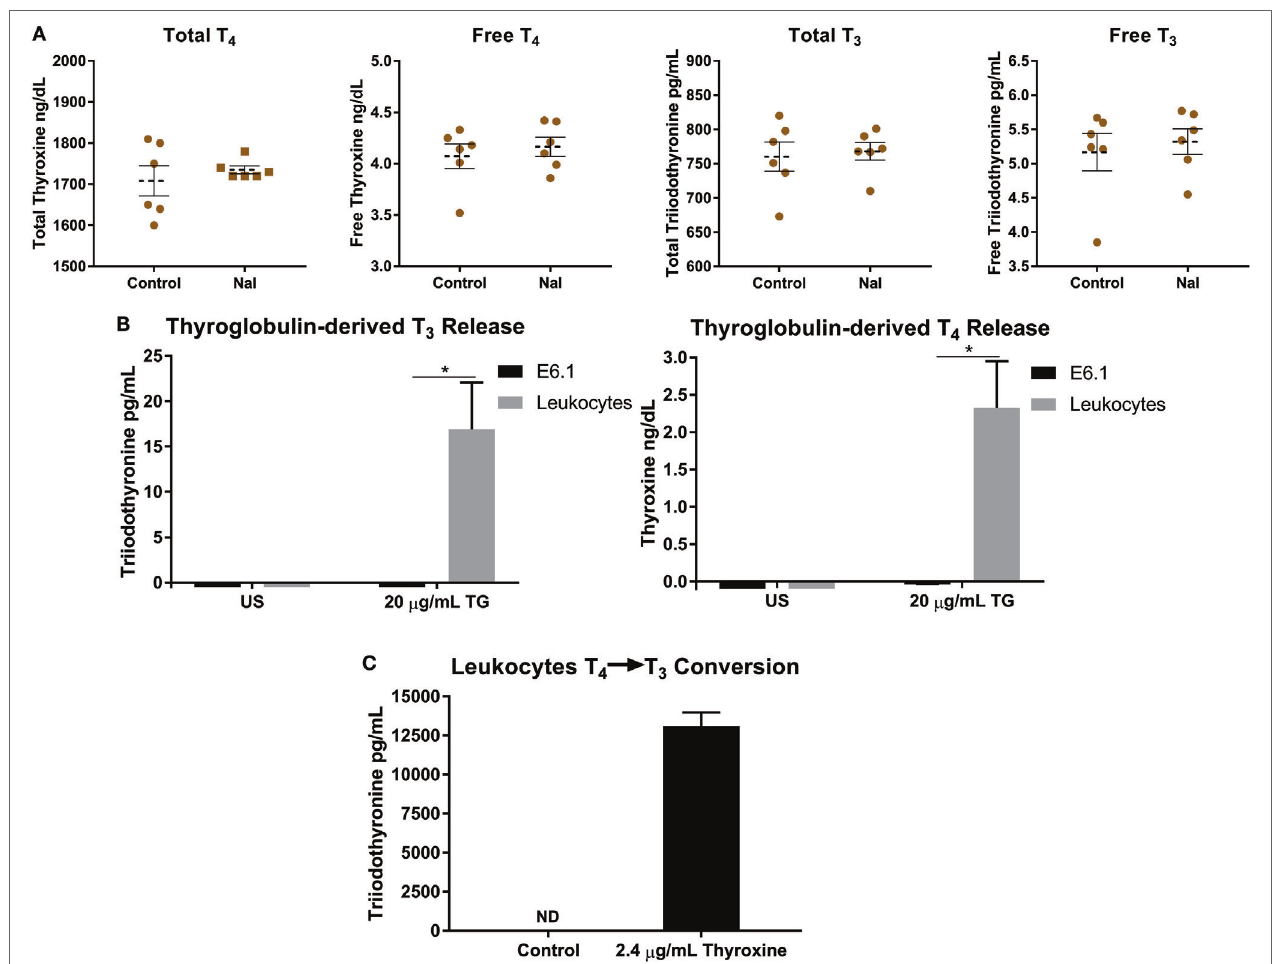
FigUre 4 | Thyroglobulin (TG) is utilized by leukocytes to increase levels of thyroid hormones. (a) 5 × 10 6 leukocytes were left unstimulated with PBS or treated with 1 mM NaI for 72 h, and then levels of total and free thyroid hormones in media were detected utilizing ECiQ diagnostic immunoassay instrument. Shown are averaged concentrations ± SEM of six donors. (B) 5 × 10 6 leukocytes were incubated with TG derived from human thyroid tissue at a concentration of 20 µg/mL for 3 days in serum free media, and then levels thyroid hormones (T 4 and T 3 ) in media were detected utilizing ECiQ diagnostic immunoassay instrument. The data were averaged after background subtraction of TG signal. Shown are averaged concentrations ± SEM of six donors. (c) Same as in panel (B) , but instead leukocytes were incubated with thyroxine (T 4 ) at 2.4 µg/mL for 2 days in serum free media. Levels of T 3 were analyzed utilizing diagnostic immunoassay instrument ECiQ. The data were averaged after background subtraction of T 4 signals. Data shown represent averaged quantifications ± SEM of six